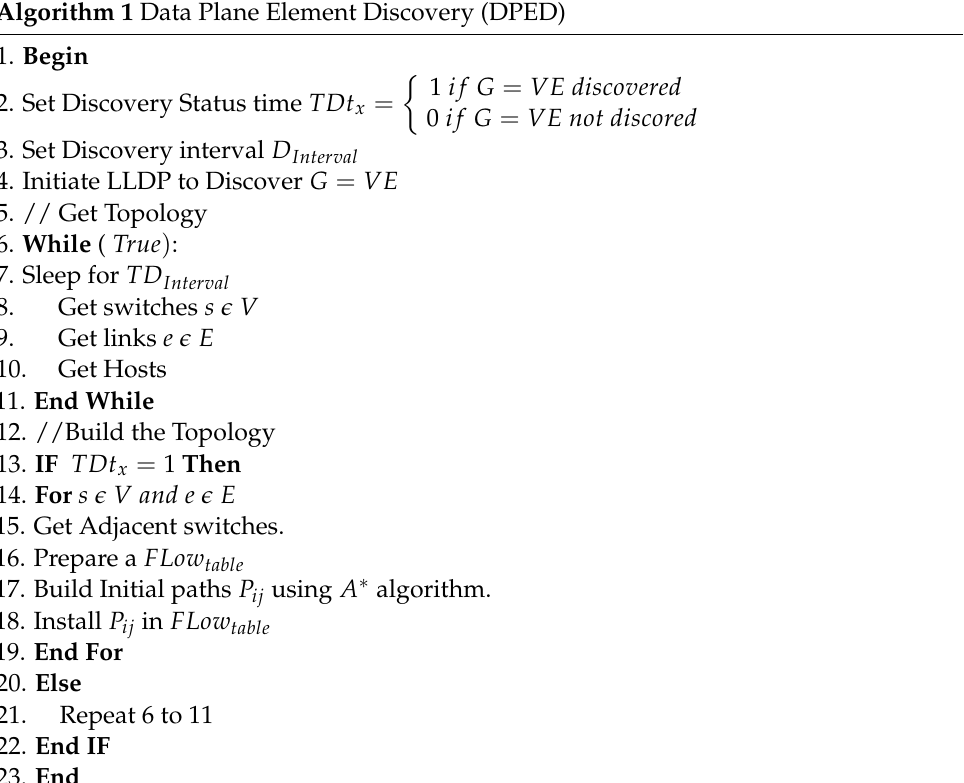
Algorithm 1 Data Plane Element Discovery